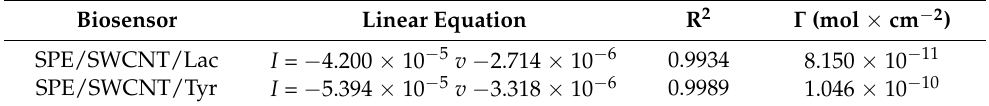
Table 2. Linear dependence equation between I and v, R 2 and the two biosensors.